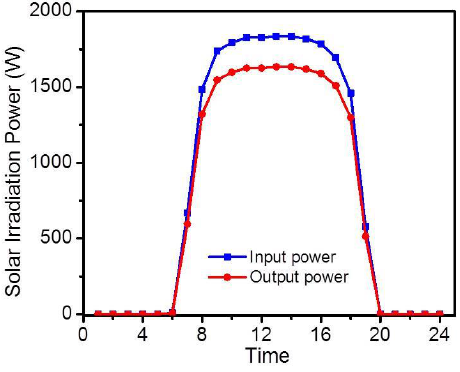
Figure 15. Power of sunlight at the collecting surface (input power) and output power from solar concentration system at different times of the day.